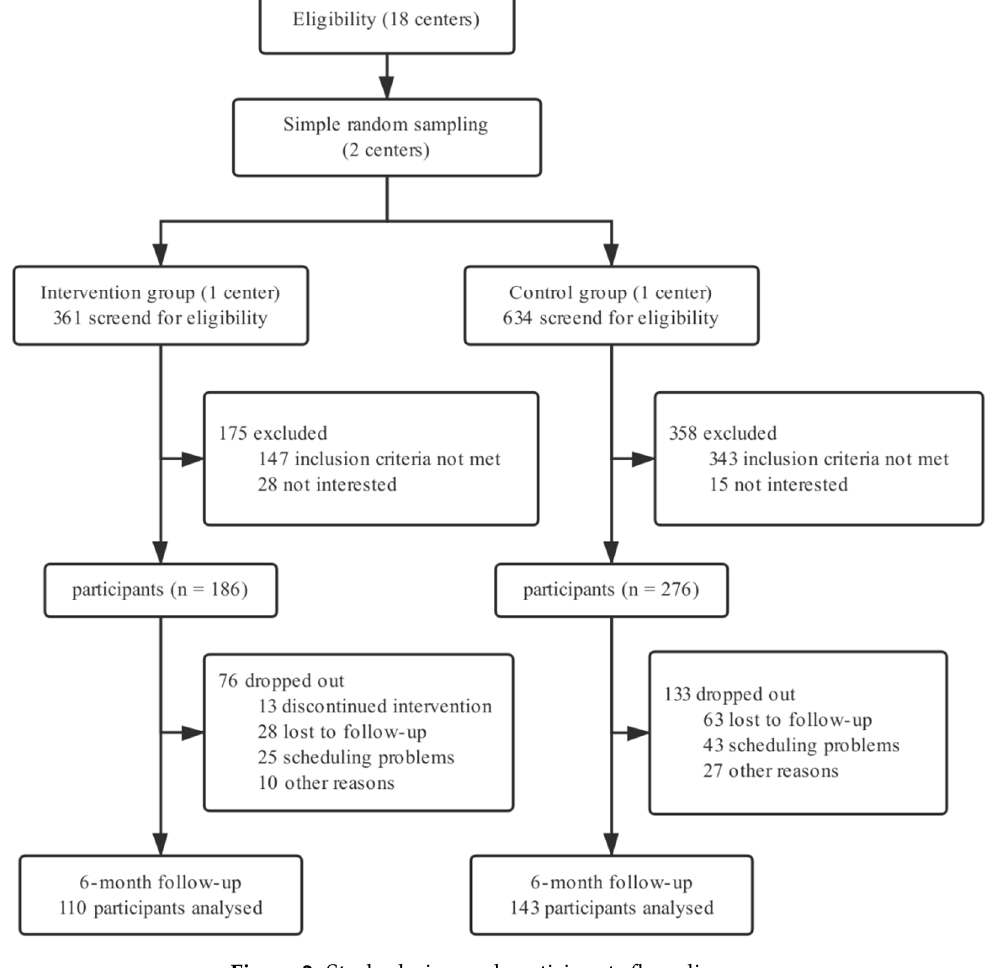
Figure 2. Study design and participants flow diagram.